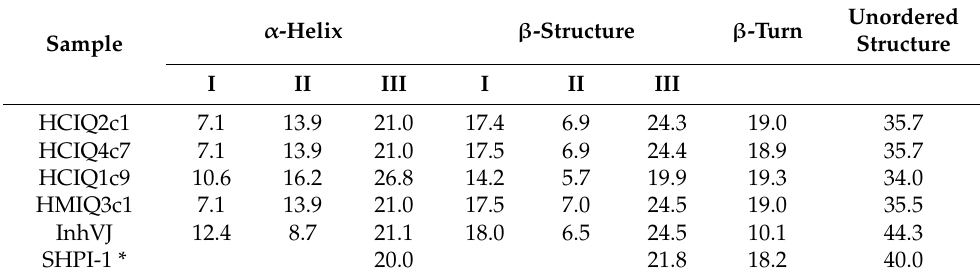
Figure 3. CD spectra of the peptides in deionized water in the far UV region. Table 1. The peptide secondary structural elements.